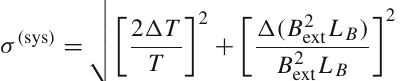
P ⊥ / P out = 3 . 5 × 10 − 7 / η 0